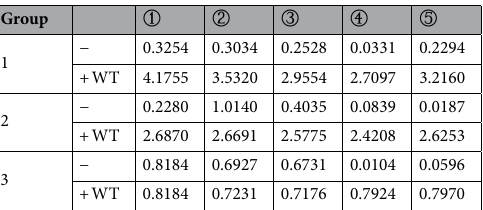
Table 4. Evaluation of vibration data of machine tools processed by different denoising